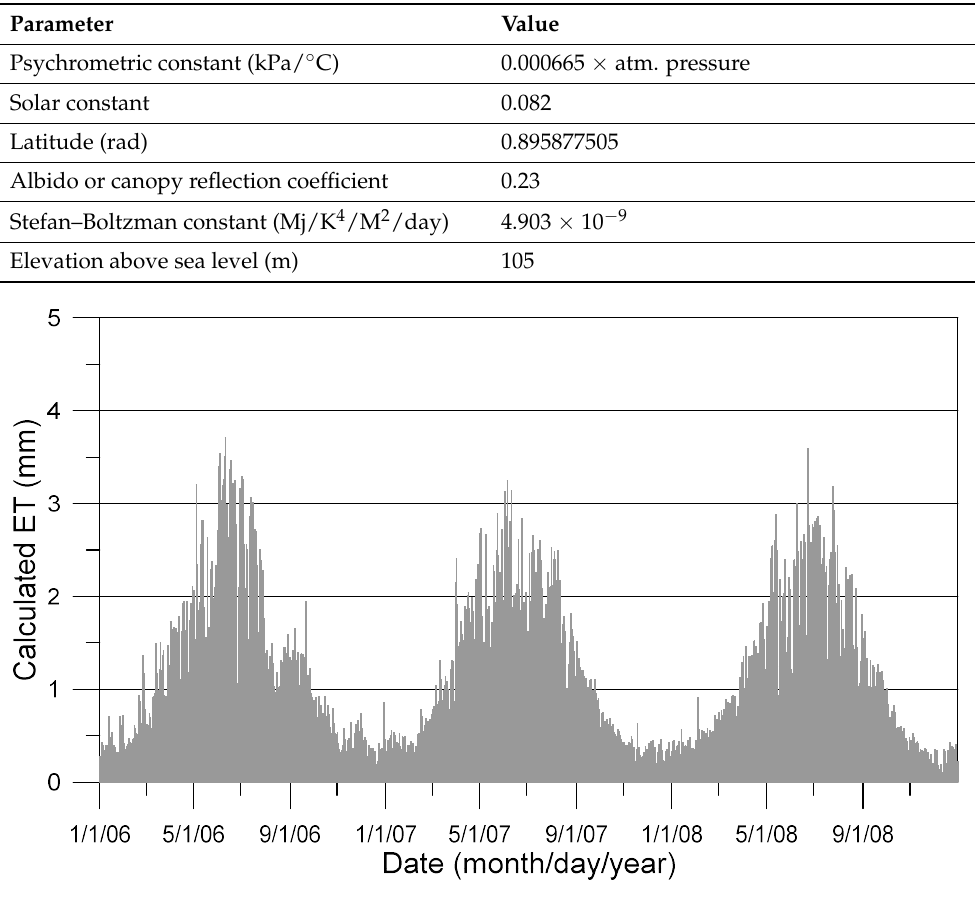
Table 2. Parameters used for the calculation of evapotranspiration.